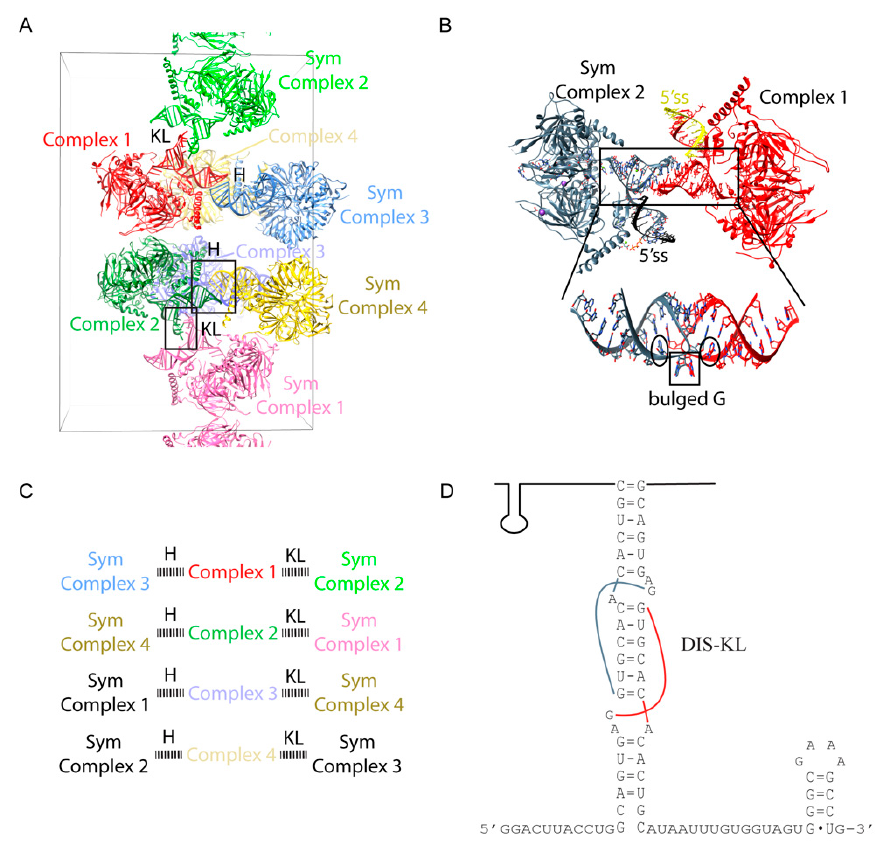
Figure 6. ( A ) The packing arrangement of the minimal U1 snRNP in the P 2 1 2 1 2 1 crystal form (PDB:4PJO). Four NCS complexes (Complex 1–4) are present in the asymmetric unit. Complexes 3 and 4 are located behind the page. Only protein-protein interactions are observed between the NCS complexes. Kissing loop interactions (KL) and end-to-end packing of the 5 ′ ss/U1RNA helix (H) are the main crystal packing interactions occurring in this crystal form. Two sets of interactions are depicted in this figure. Complex 1 forms a KL interaction with the symmetry-related Complex 2 and a continuous duplex stacking with the symmetry-related Complex 3. Complex 2 forms a KL interaction with the symmetry-related Complex 1 and a continuous duplex stacking with the symmetry-related Complex 4. An example of this cyclical packing arrangement is summarized in C. ( B ) An example of the KL interaction formed between Complex 1 and the symmetry-related Complex 2. Unlike the original DIS kissing loop complex crystal structure (PDB:1XPE), in which two bulged purines form crystal contacts lateral to the stems, only one purine is bulged out to stack with the equivalent nucleotide. The other purine forms a non-canonical base pair with the unpaired A 3 ′ to the 6-nt kissing loop complex. ( C ) An example of the packing arrangement involving kissing loops (KL) and continuous end-to-end stacking of the 5 ′ ss/5 ′ U1 duplex (H). Complex 1 interacts with 2–4 in the NCS via protein contacts only. Each NCS complex makes the same packing arrangement with the same set of symmetry-related complexes. The text color for each complex is the same as those depicted in A. Text color in black are complexes that are not shown in A. ( D ) Secondary structure of the RNA construct used in the P 2 1 2 1 2 1 crystal form.